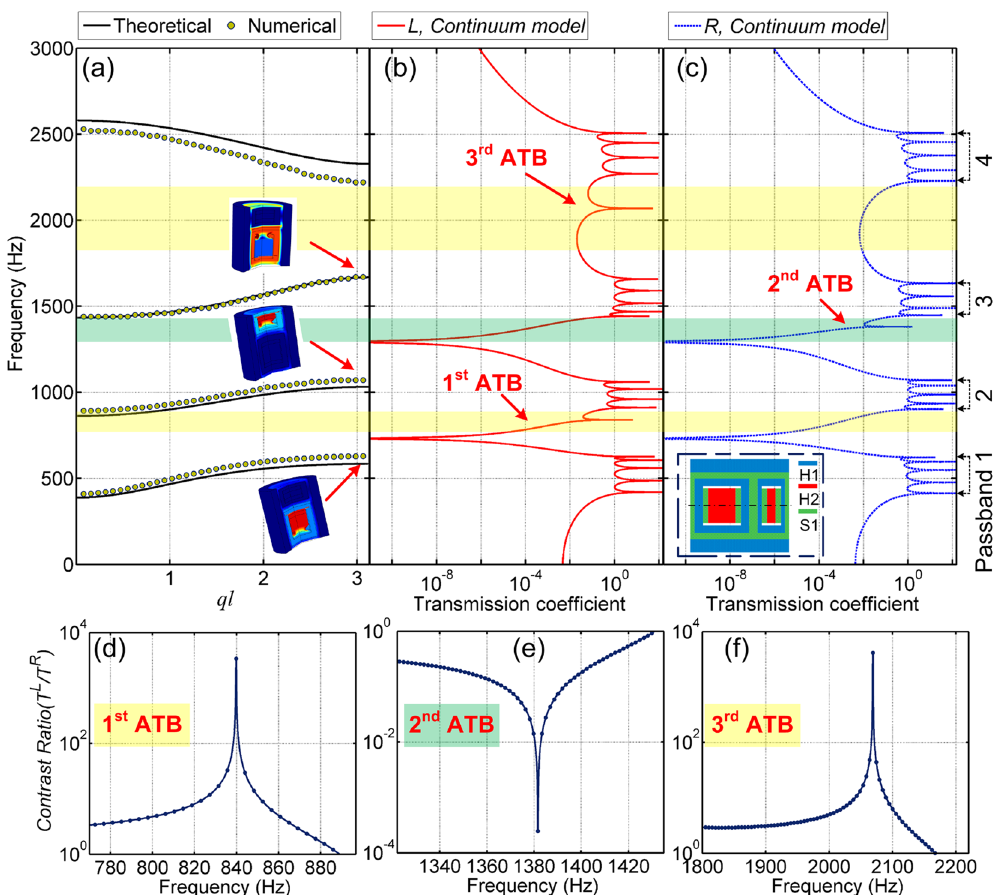
Figure 3. ( a ) Theoretical and numerical dispersion relations of the infinite periodic rod. Numerical FRFs for ( b ) directions L and ( c ) R for a finite continuum rod consisting of 6 unit cells. Insert in ( c ) shows the periodic unit cell of continuum rod. The profiles of asymmetric contrast ratio obtained in the ( d ) 1 st , ( e ) 2 nd and ( f ) 3 rd ATBs in the finite continuum rod